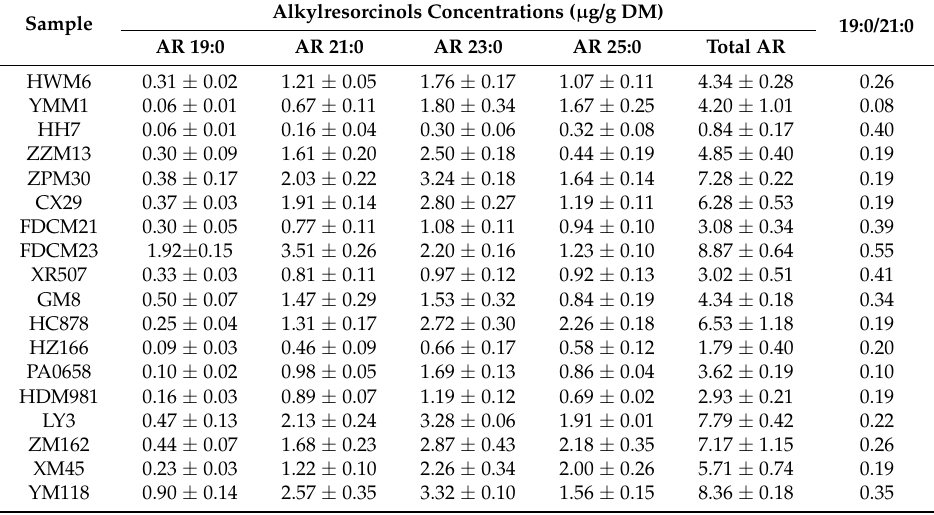
Table A2. Total ARs and their homologues concentrations on seed surface from 36 wheat samples cultivated in 2017 in